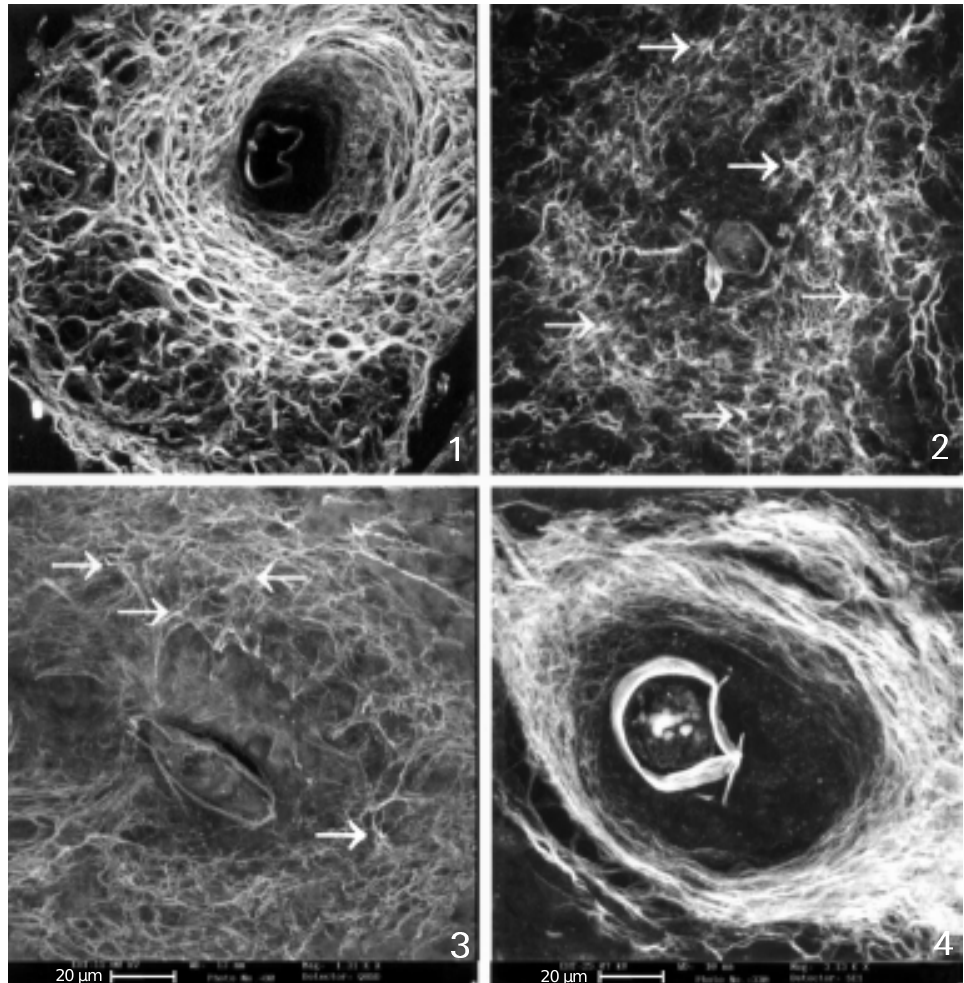
(BH) isolate of S. mansoni . The mice were